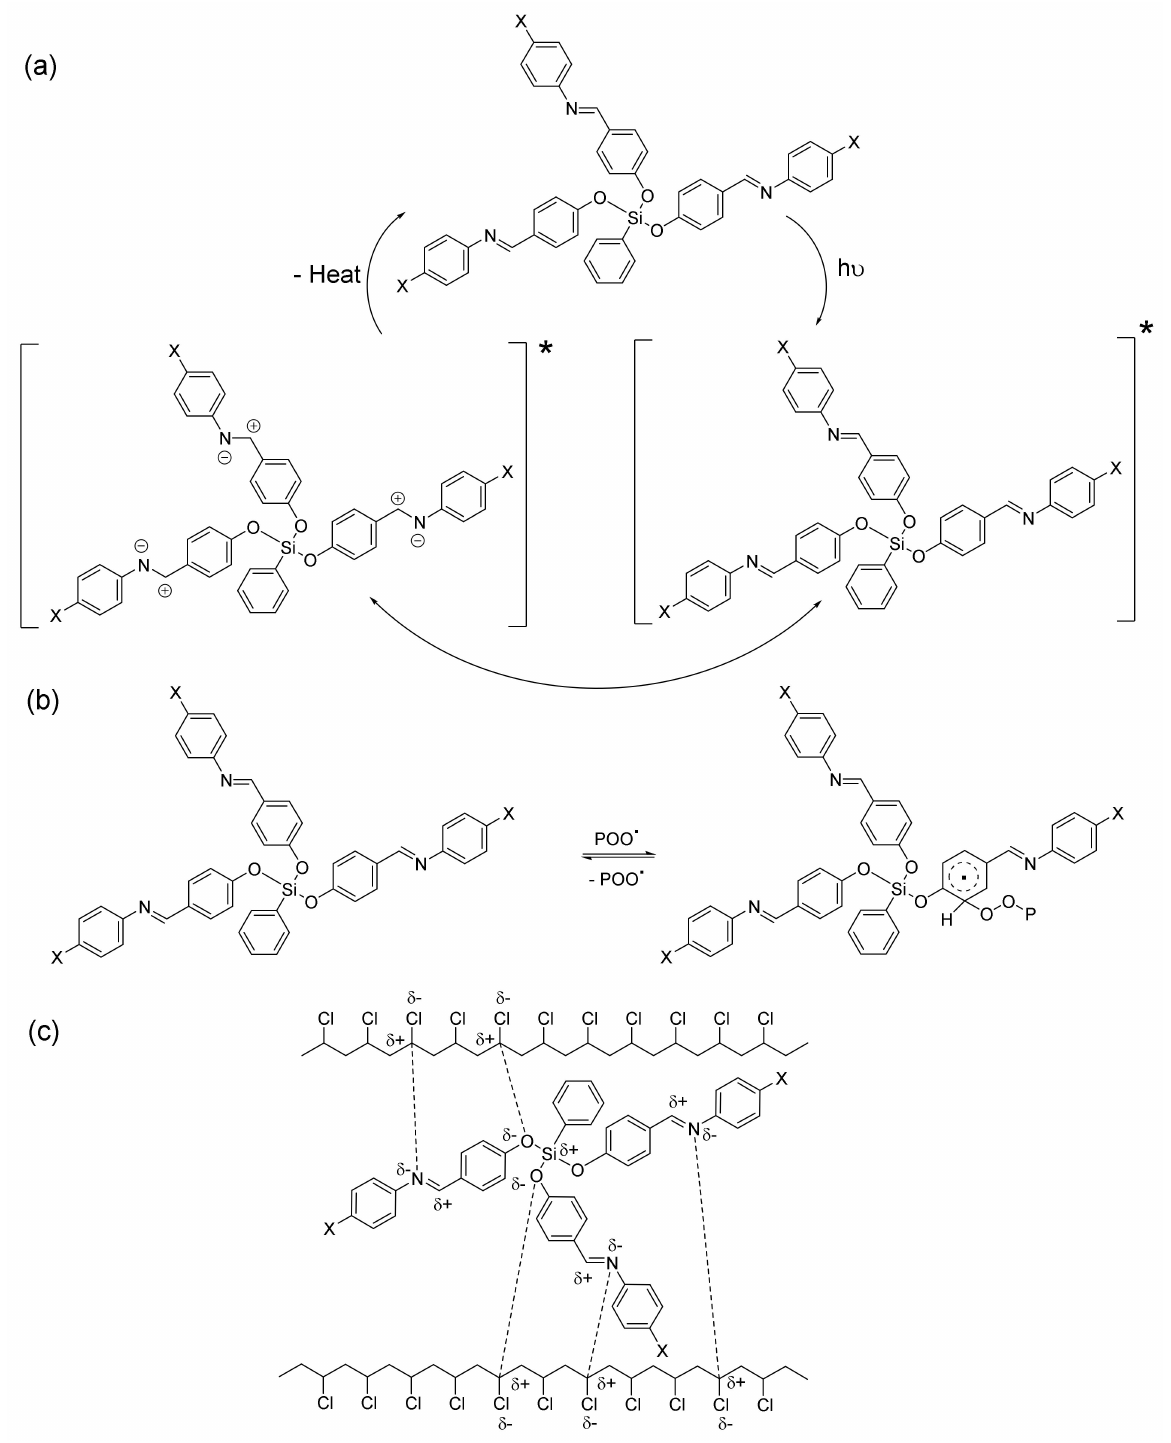
Figure 5. Organosilanes 1 – 3 act as: ( a ) UV irradiation absorbers, ( b ) radical scavengers and ( c ) stabilizers though the forma- tion of coordination bonds with the polar C–Cl bonds within the PVC